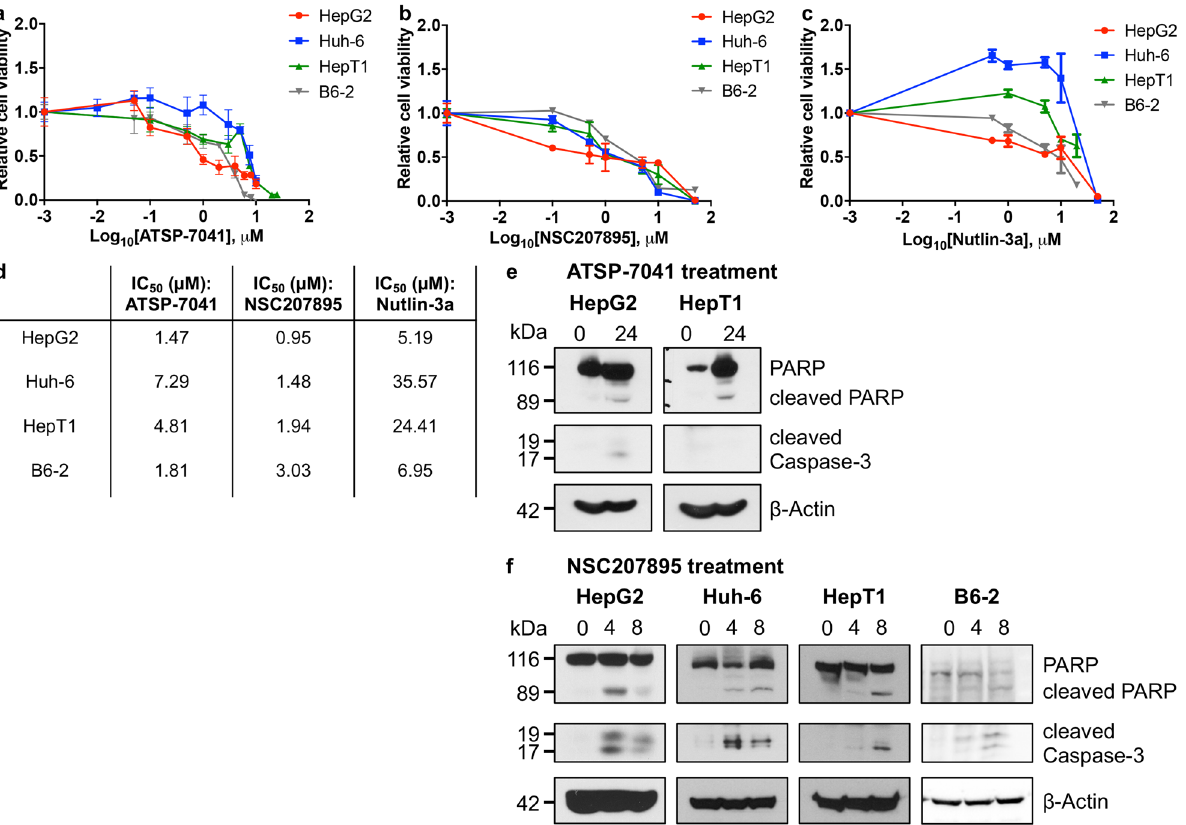
Figure 2. MDM4 inhibition with ATSP-7041 and NSC207895 lead to apoptosis of HB cell lines. ( a ) HepG2, Huh-6, HepT1, and B6-2 cells were exposed to varying indicated concentrations of ATSP-7041 for 48 h. MTT assays were performed at 48 h to assess viability. Error bars represent SD. Data shown are representative of at least three independent experiments performed with three replicate wells each time. ( b ) HepG2, Huh-6, HepT1, and B6-2 cells were exposed to varying indicated concentrations of NSC207895 for 48 h. MTT assays were performed at 48 h to asses viability. Error bars represent SD. Data shown are representative of at least three independent experiments performed with three replicate wells each time. ( c ) HepG2, Huh-6, HepT1, and B6-2 cells were exposed to varying indicated concentrations of Nutlin-3a for 48 h. MTT assays were performed at 48 h to asses viability. Error bars represent SD. Data shown are representative of at least three independent experiments performed with three replicate wells each time. ( d ) IC 50 values determined in the assays shown in ( a – c ). (e) Protein lysis from cells treated with 10 μM ATSP-7041 for 24 h was compared to that from untreated cells (0 h). Immunoblotting for total PARP, PARP cleavage, and Caspase-3 cleavage was